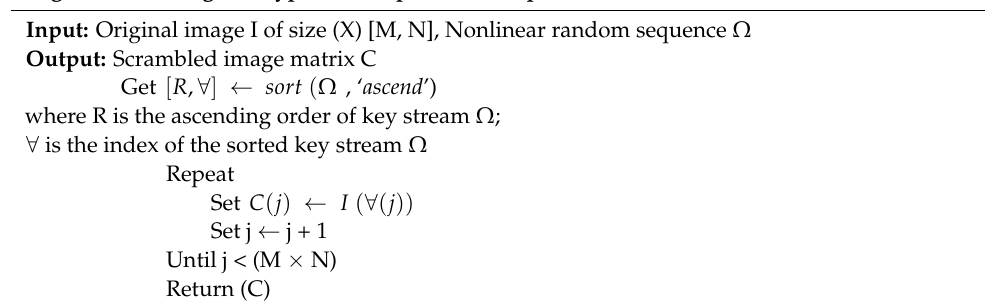
Algorithm 3: Image encryption—Hopfield based